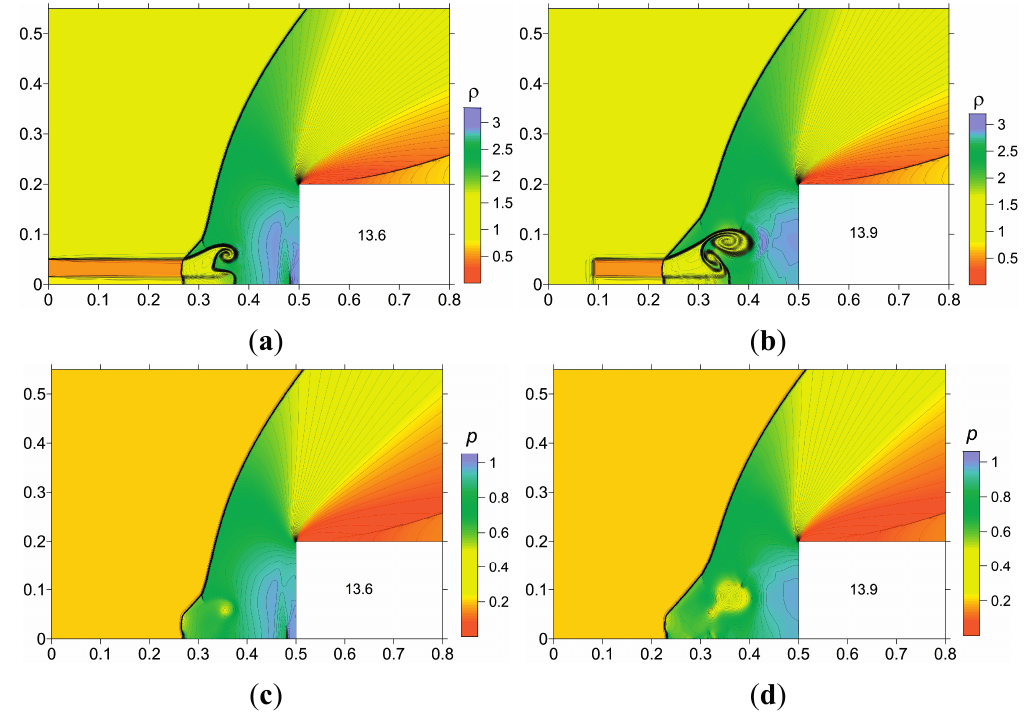
Figure 3. Generation of two vortices rotating in opposite directions as the result of the Richtmyer–Meshkov instabilities, d/D = 0.25, d 1 /D = 0.075, α ρ = 0.5, α ρ 1 = 0.75: ( a , b ) Density fields; ( c , d ) Pressure